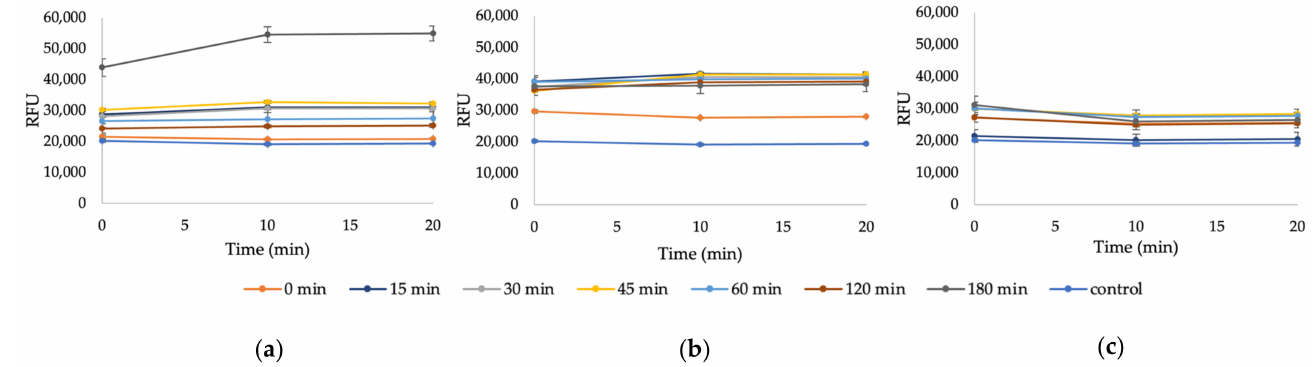
Figure A4. The RFU of Whatman filter paper after 0–3 h of 64% sulfuric acid hydrolysis at 45 ◦ C ( a ) be- fore centrifugation, ( b ) after one centrifugation (6000 rpm, 15 min), and ( c ) after two centrifugations (6000 rpm, 15 min); 0.4% KOH (pH = 13), 0.1%